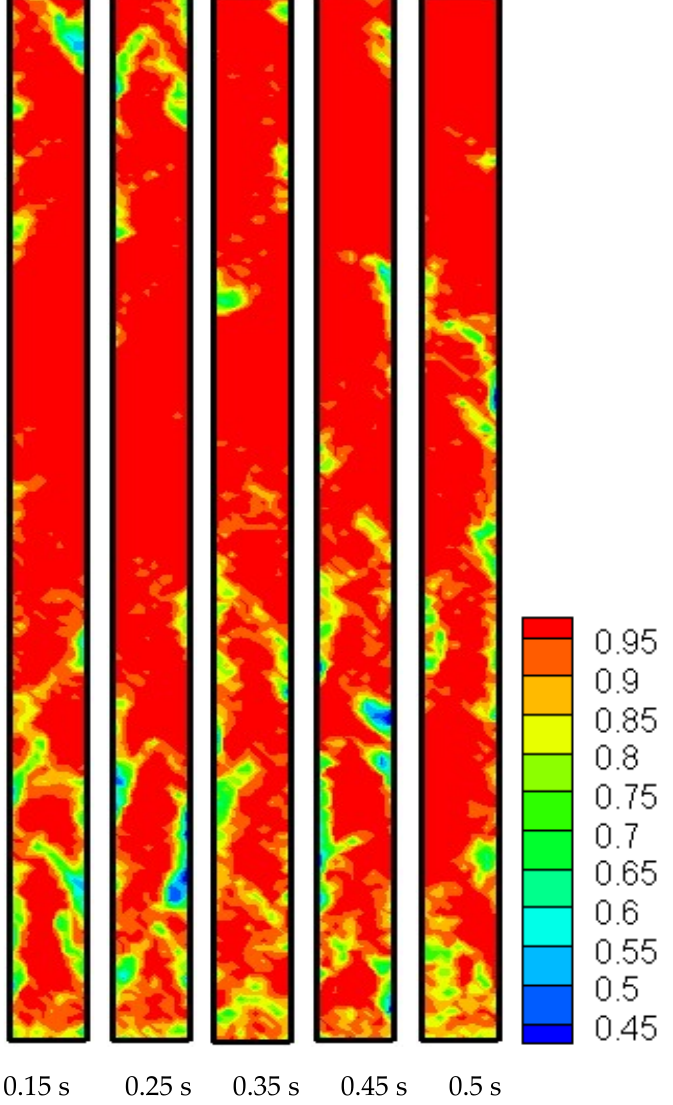
t . Figure 7. Voidage with moderate t r = r